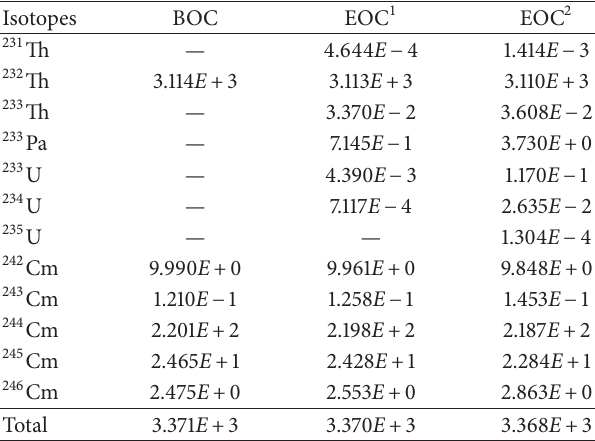
Table 8: Masses of actinide isotopes [kgHM] at the beginning and at the end of the cycle (Case